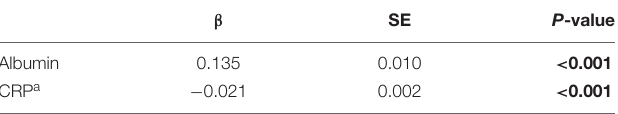
TABLE 4 | β coefficients of fish oil use for blood indicators from general linear regression analysis in the UK